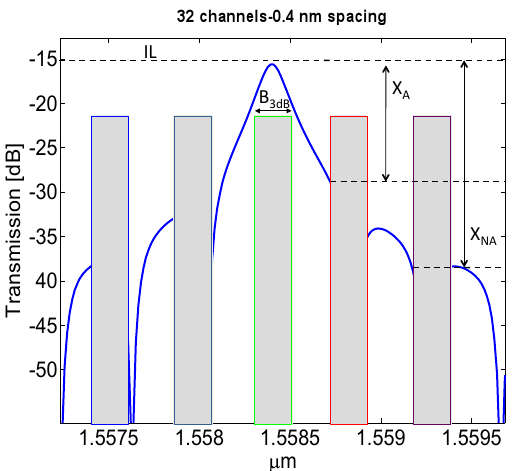
Figure 4. Backplane transfer function of a certain TX-RX pair.